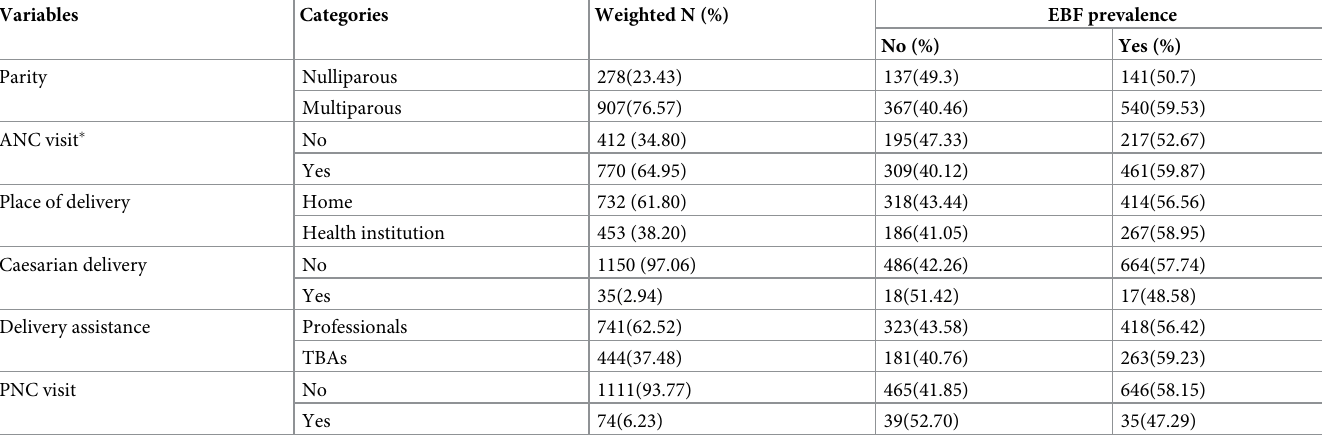
Table 3. Maternal obstetric and healthcare-related characteristics in Ethiopia, 2016 (n =